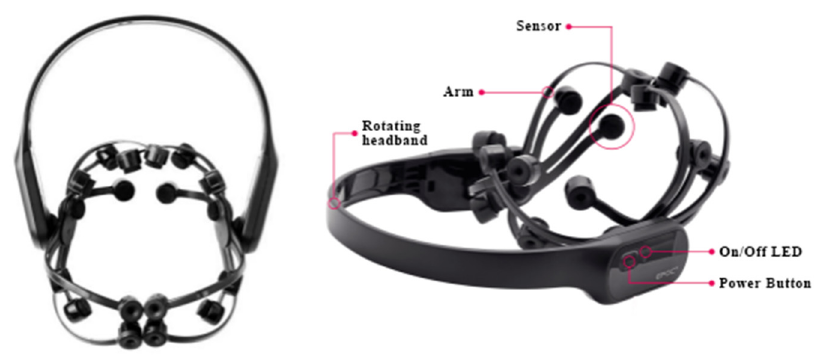
Figure 3. Consumer-grade brain–computer device Emotiv Epoc Figure 3. Consumer ‐ grade brain–computer device Emotiv Epoc X.